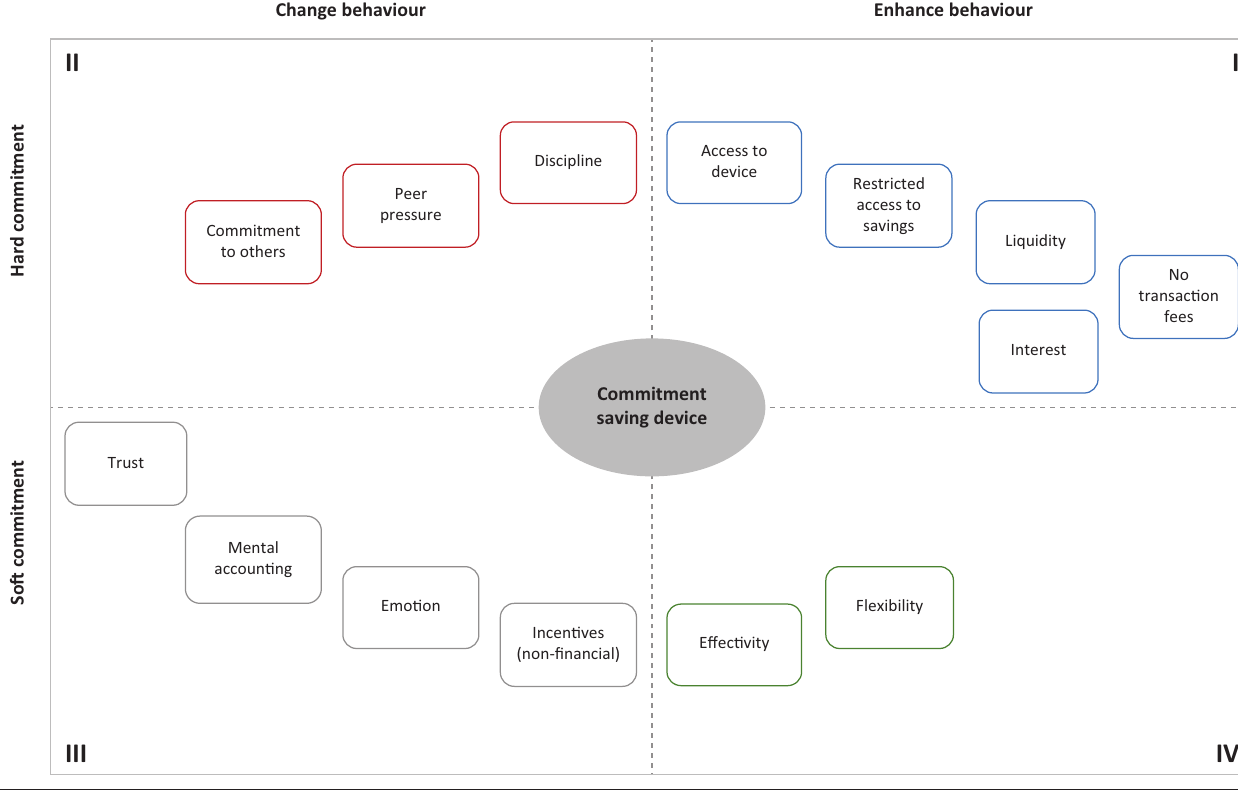
FIGURE 3: Behavioural design framework for commitment saving